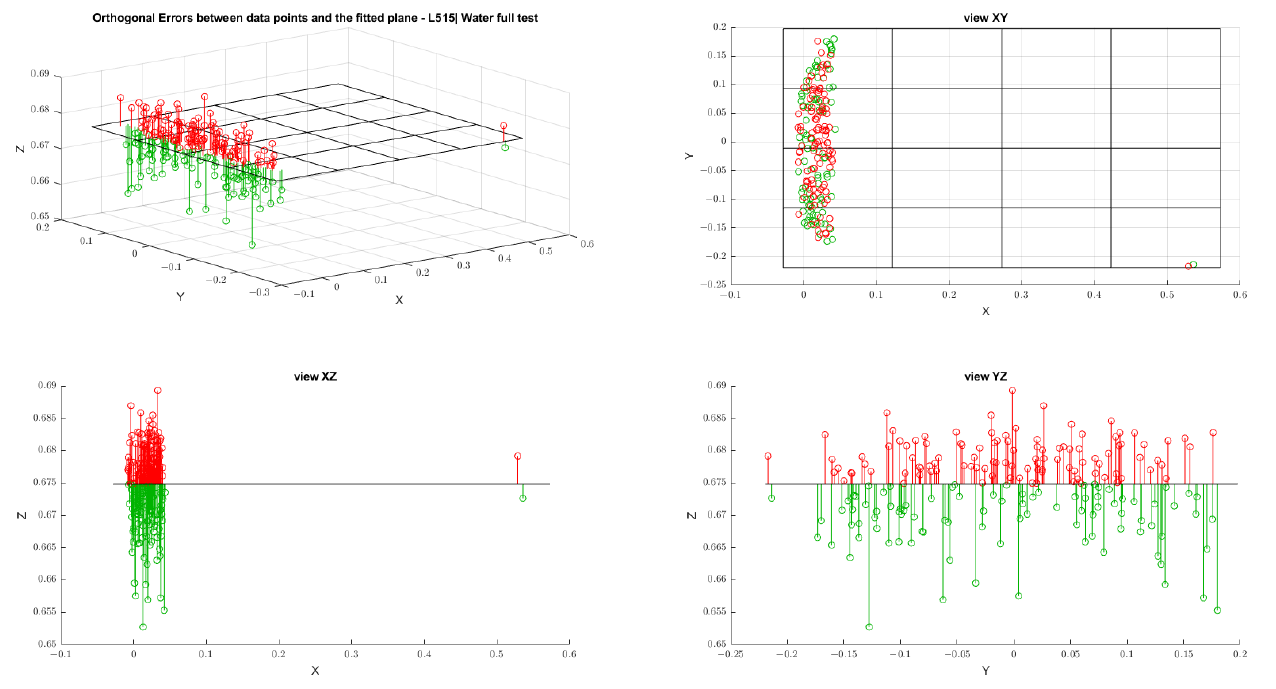
Figure A10. Results of orthogonal errors for the L515 camera referring to the water full